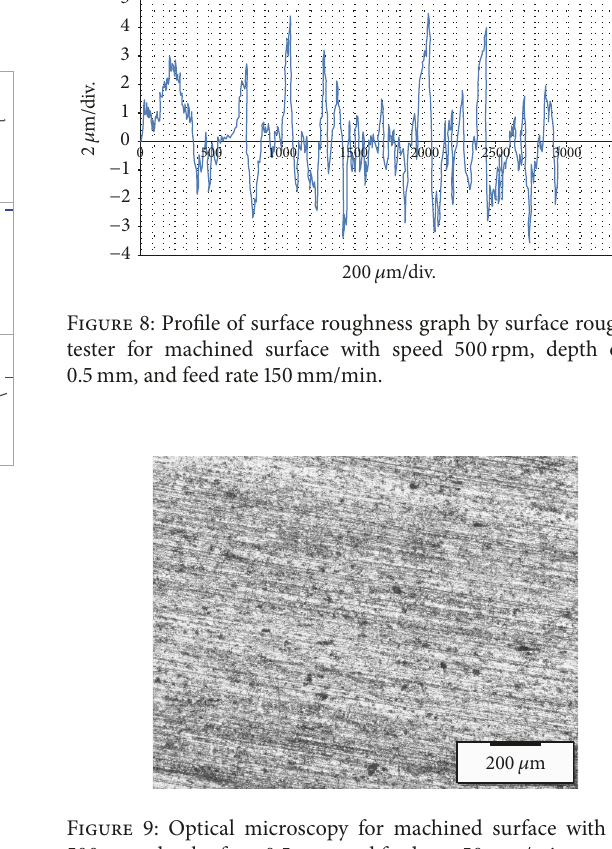
Figure 9: Optical microscopy for machined surface with speed 500 rpm, depth of cut 0.5 mm, and feed rate 50 mm/min.